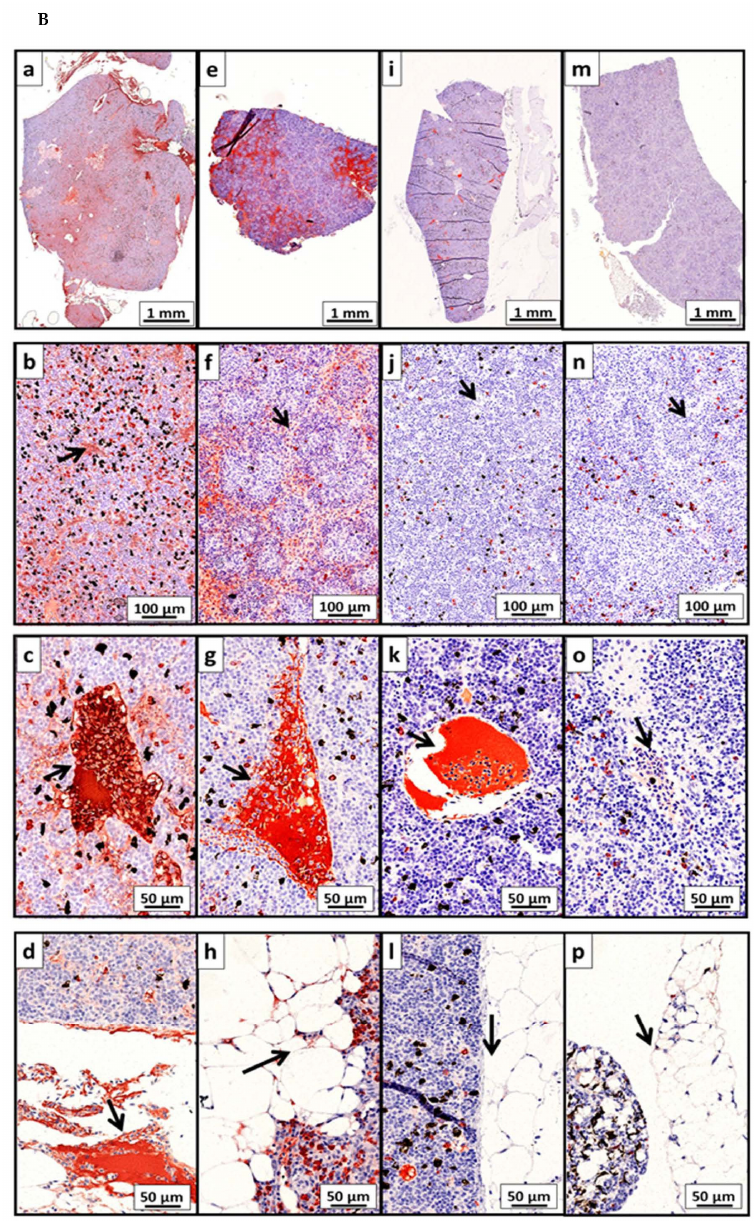
Figure 8. Immunohistochemical analysis of IgM P33-vaccinated fish. ( A ) Column scatter plots showing the difference in IHC scoring of secreted IgM labeling intensity ( a , c ) and abundance of IgM+ cell ( b , d ) in anterior kidney ( n ≥ 8/group) and spleen ( n ≥ 10/group) between the mock-vaccinated (injected with phosphate-buffered saline [PBS]) and P33-vaccinated (high dose [HD]) fish at 14 weeks post-vaccination (wpv). Each dot represents the average score of five microscopic fields on one tissue section obtained from one fish, and the red dots represent tissue sections in the pictures in panel ‘B’. Asterisks denote significant differences *** p < 0.001) and the horizontal lines on the plots show the median values. ( B ) IgM labeling (red color) in IHC demonstrating the difference in intensity and distribution of secreted and cell-associated IgM in the anterior kidney ( a – d , i – l ) and spleen ( e – h , m – p ) between PBS-injected ( a – h ) and P33-vaccinated ( i – p ) fish at 14 wpv. The images show IgM staining in the whole tissue section ( a , e , i , m ; 2 × magnification), the splenic red pulp (arrows in f , n ; 20 × magnification), sinusoids in anterior kidney (arrows in b , j ; 20 × magnification), large blood vessels (arrows in c , g , k , o ; 40 × magnification), and the visceral tissue around spleen and kidney (arrows in d , h , l , p ; 40 ×